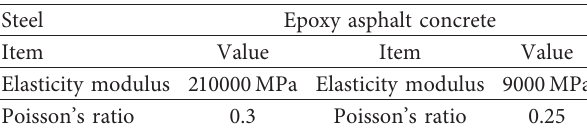
Figure 8: Critical segment model diagram. Table 1: Material parameters used in the segment